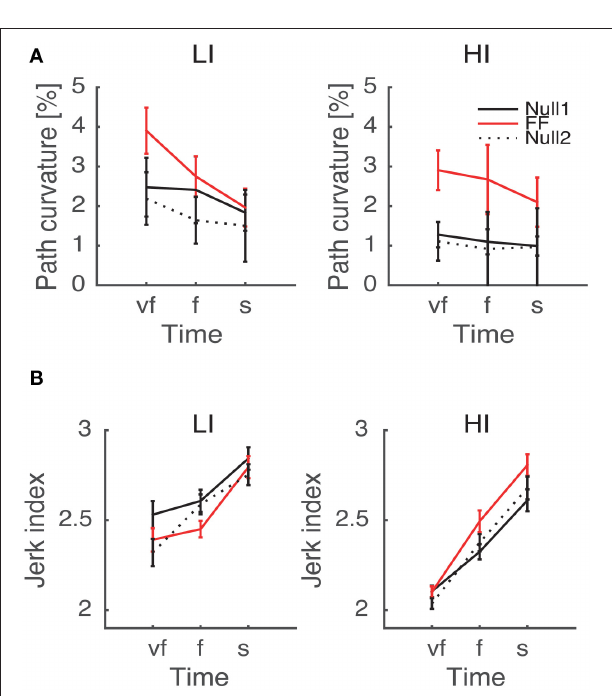
FIGURE 5 | Path curvature (A) and Jerk index (B) vs. Movement Time (negative velocity-dependent field, B − ), for Low inertia (LI, left) and high inertia (HI, right). Curves are averaged over subjects for each velocity constraint and for each phase – Null1 (black), FF (red), and Null2 (dotted black). The differences between Null1 and FF indicate perturbation effects. The differences between Null1 and Null2 indicate carryover effects. Vertical bars denote the SE